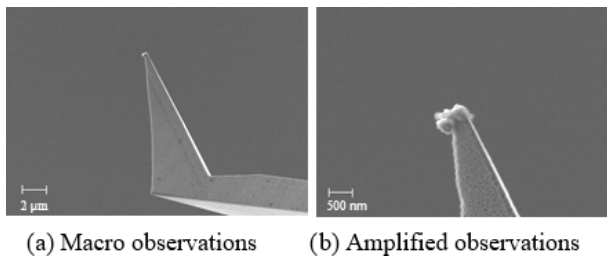
Figure 10. Adhesion position of silver nanocluster particles on the AFM probe.